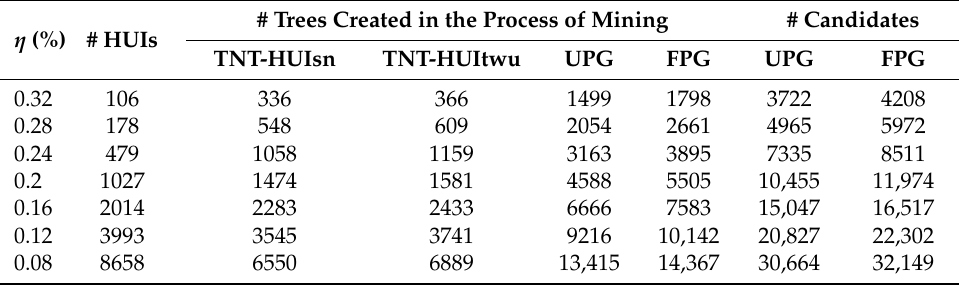
Table 7. Details analysis on the dataset